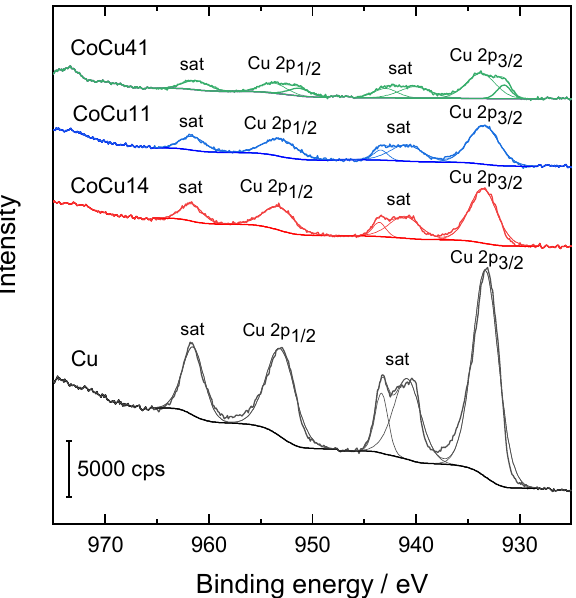
Figure 6. The Cu 2p XPS spectra of the Co-Cu oxide catalysts.